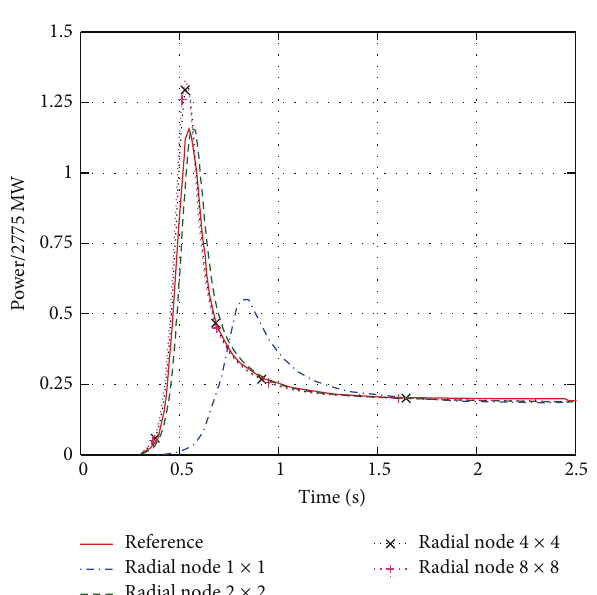
Figure 4: Effect of radial node number per assembly on the power peak for case C1.